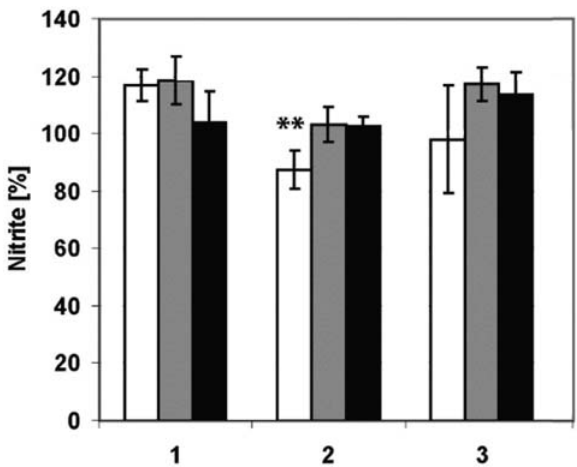
Figure 5. Influence of compounds 1 – 3 on nitrite accumulation in culture medium. Substances were tested at 1 μM (dark grey bars), 10 μM (light grey bars) and 100 μM (white bars). Data is presented as mean percentage ±SD in comparison to control cells. n = 9 from three independent